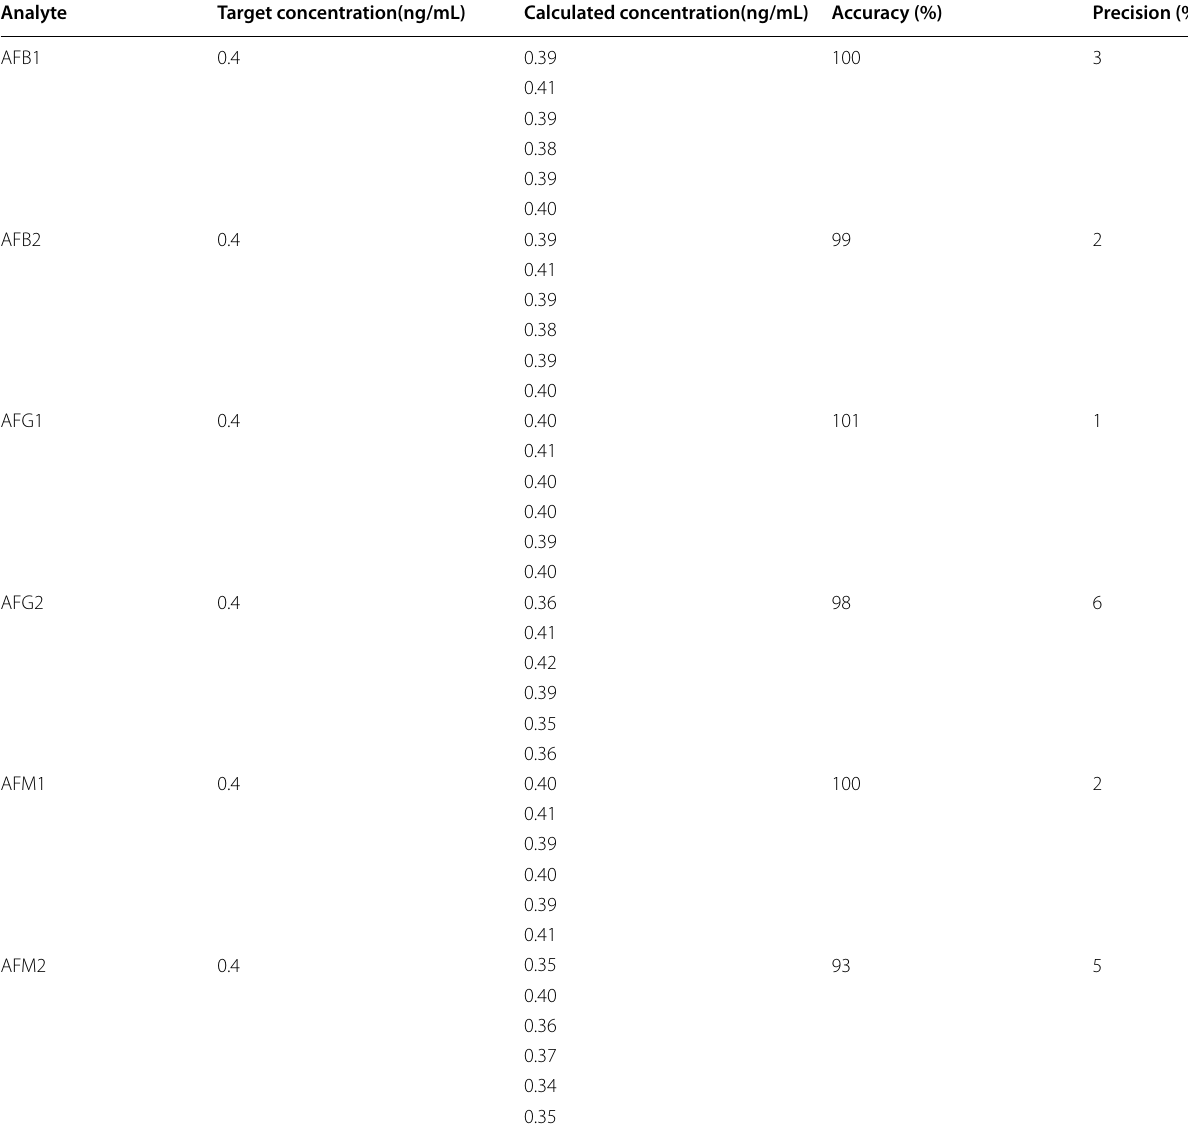
Table 5 Concentration, precision, and accuracy of diluted samples